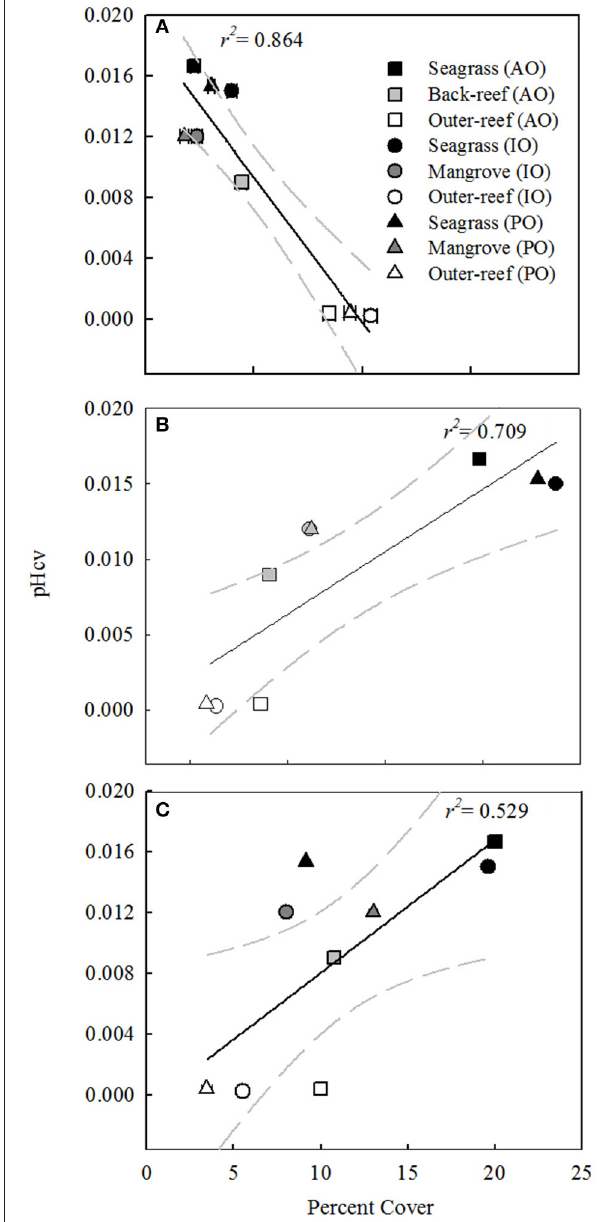
FIGURE 3 | Plots of pH Coefficient of Variation ( CV ) vs. the percent cover ( ± standard error) of: (A) calcifying benthic photoautotrophs (scleractian hermatypic and ahermatypic, coralline algae and calcifying algae, (B) non-calcifying benthic photoautotrophs (seagrass, macro- and turf algae) and (C) non-calcifying benthic photoautotrophs excluding the Thalassia spp. of seagrass, for associated-reef habitats and an outer-reef site in the Atlantic (AO), Indian (IO), and Pacific Oceans (PO). Benthic composition data is averaged from three 30m benthic transects. Regression is shown with 95% confidence interval (gray dashed